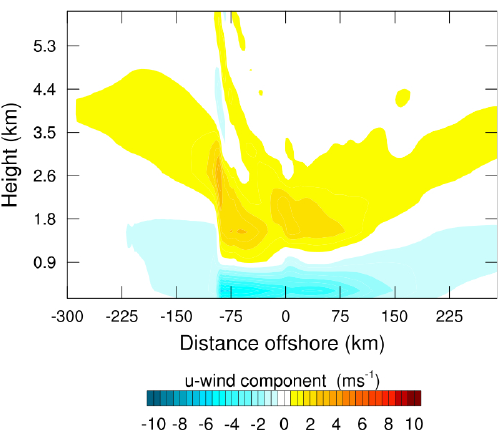
Fig. 9. The u-wind component (ms − 1 ) of a mature sea breeze at 19:00UTC for the baseline single coast case using the YSU PBL scheme and a SST of 287K. Negative values indicate onshore flow.